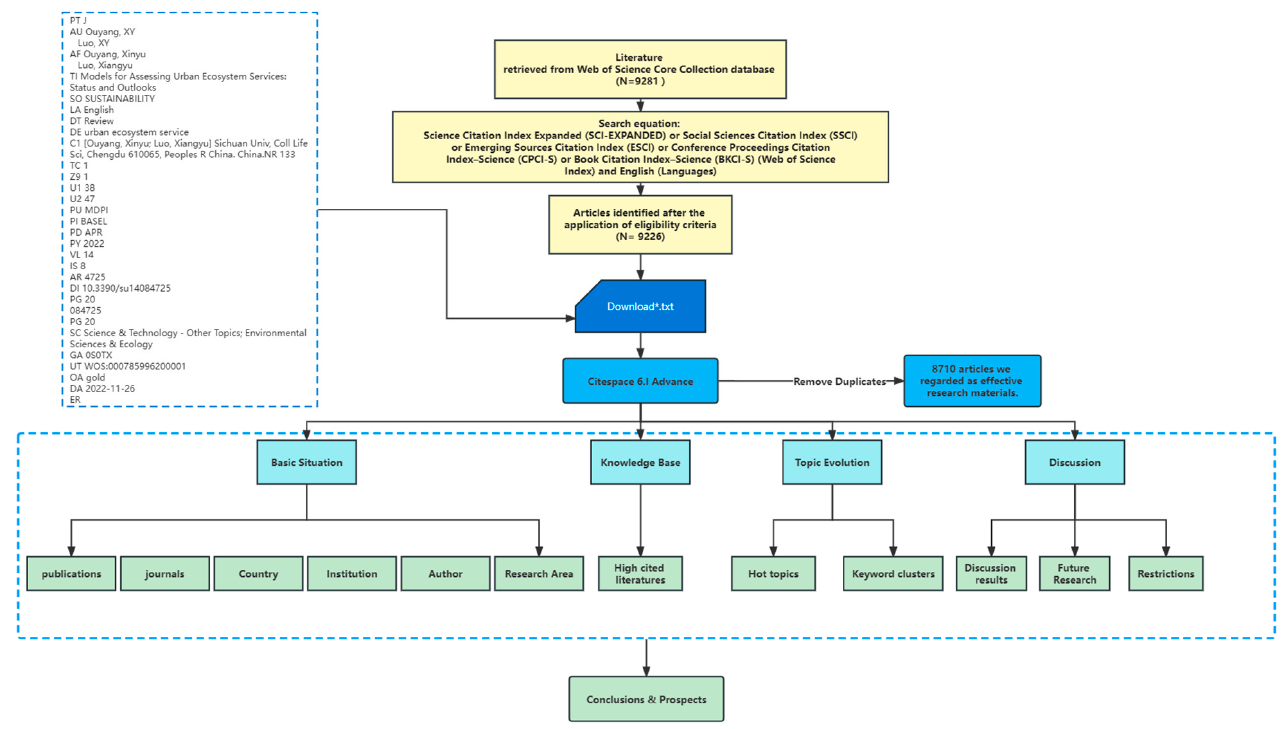
Figure 1. Outline of UES research design.